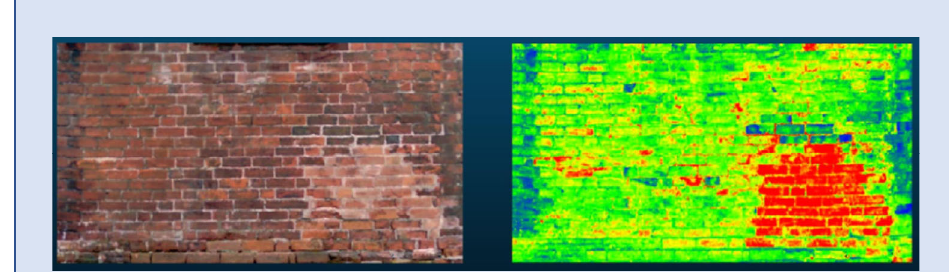
Figure A1. Methodology and metrics of the presented research programme.